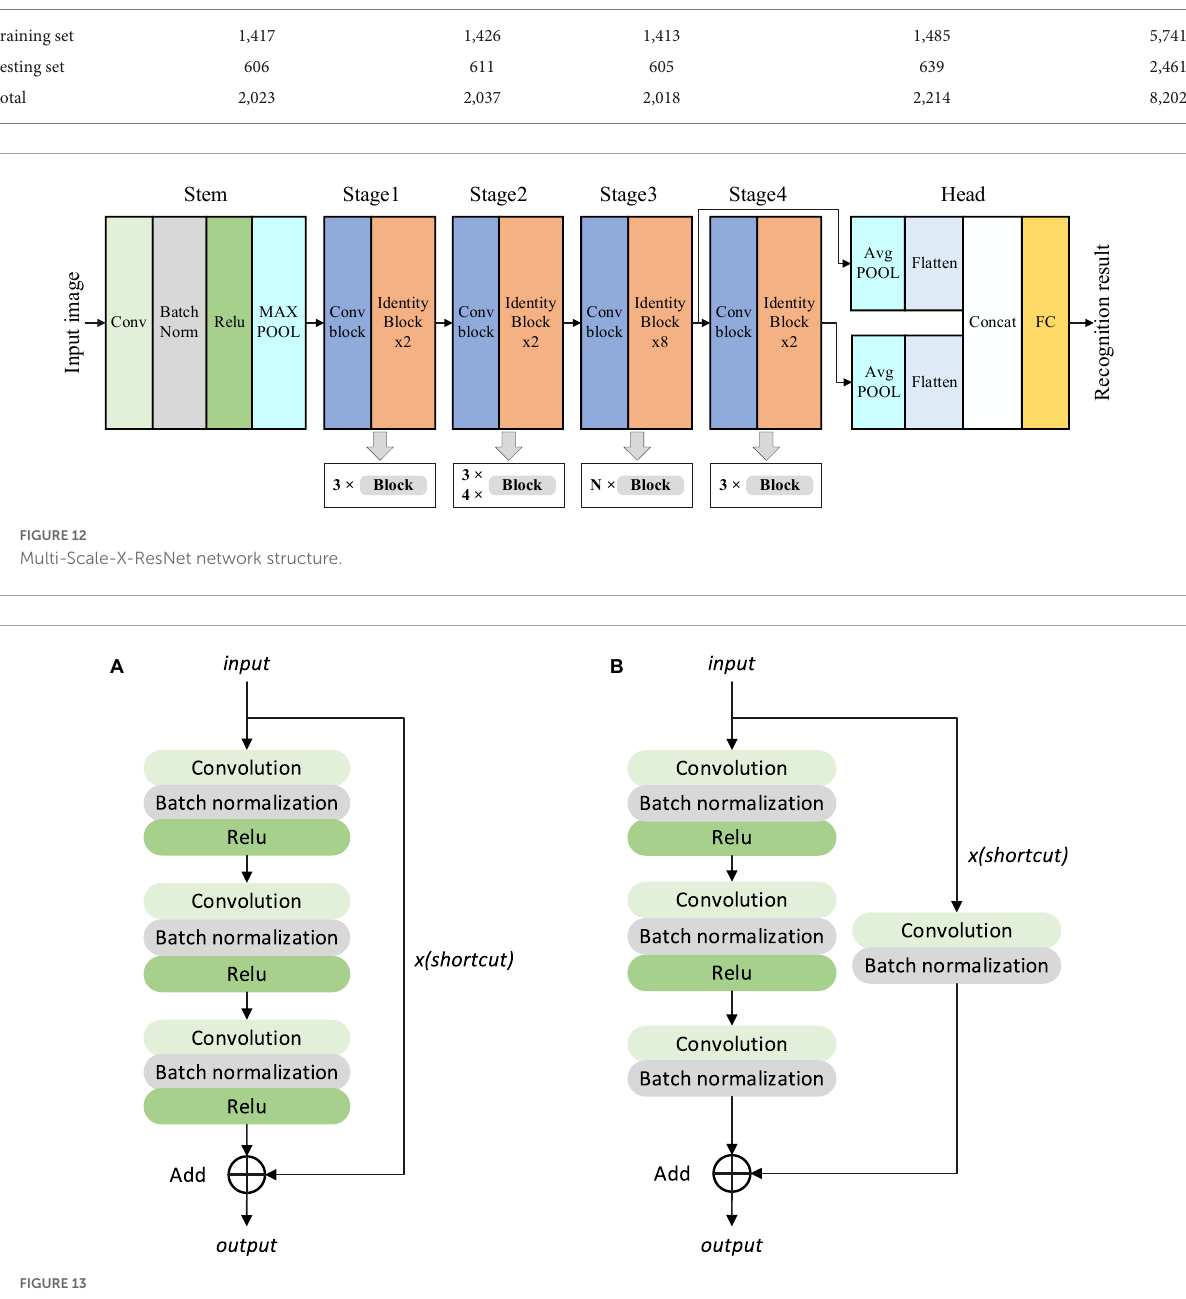
FIGURE13 Structure of identity mapping module and convolution module in a residual neural network (A) identity block, (B) Conv block.